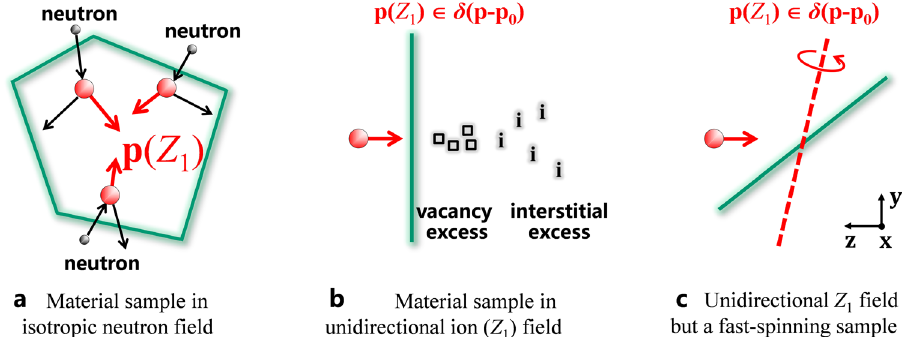
Fig. 1 Illustration of the momentum distribution for the fi rst-generation energetic ions ( Z 1 s). a Momentum distribution is nearly-isotropic in reactor-based damage. b Momentum monodispersity in accelerator-based damage. c A proposed sample spinning strategy to mitigate the momentum monodispersity of ion-beam